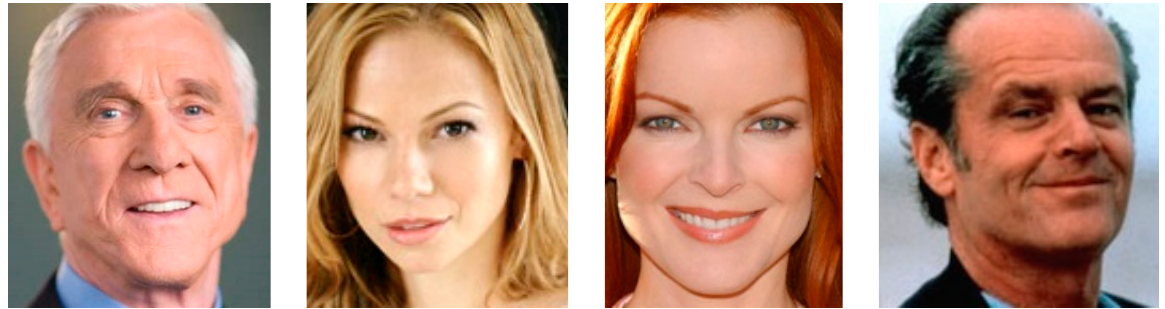
Figure 5. Sample visible face images from the FaceScrub dataset.